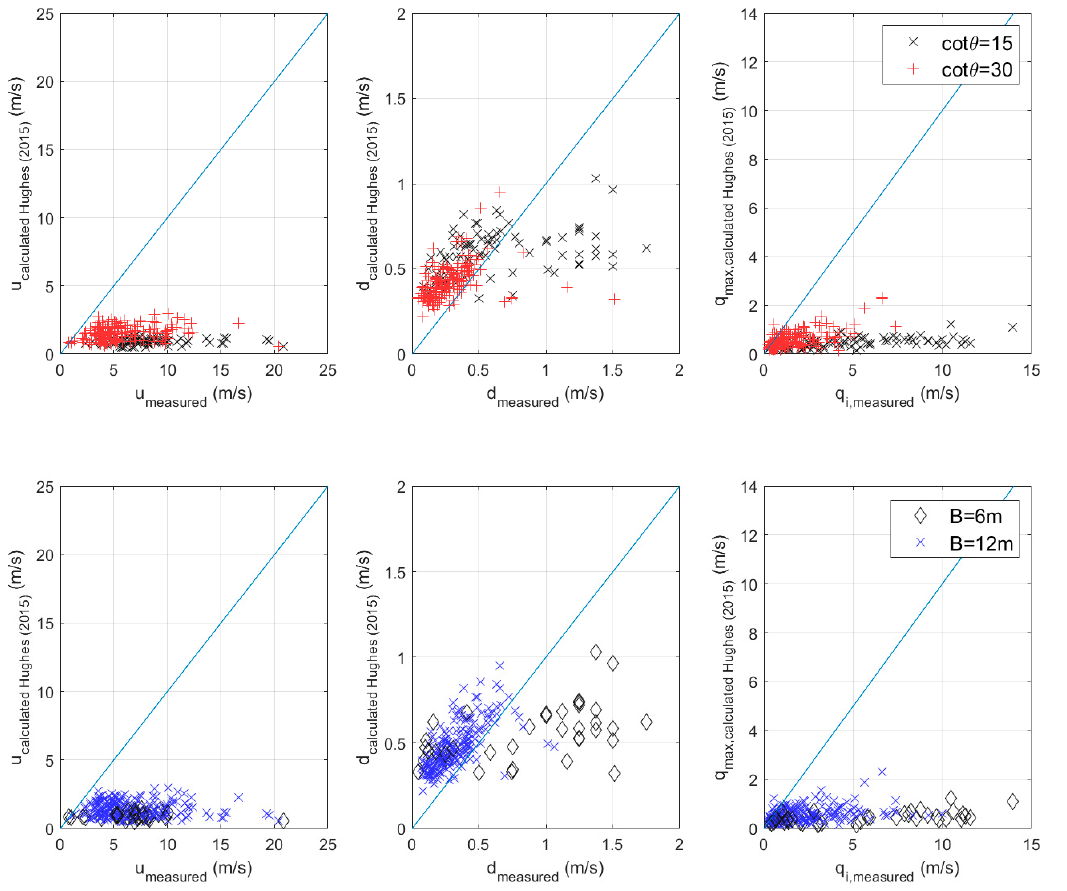
Figure 17. Estimation of overtopping flow depth and velocity employing formulas by Hughes (2015).